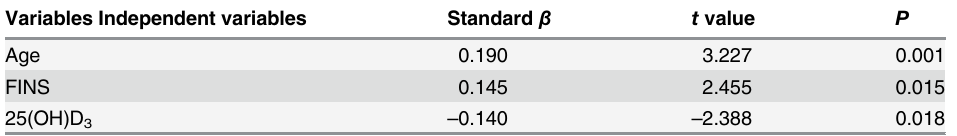
Table 4. Independent factors of C-IMT identified by multiple linear regression analysis of a healthy subgroup.